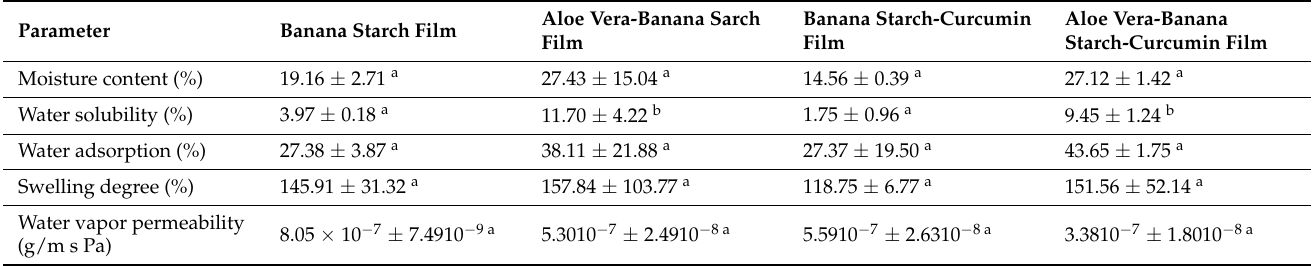
Table 2. Water-resistance properties of